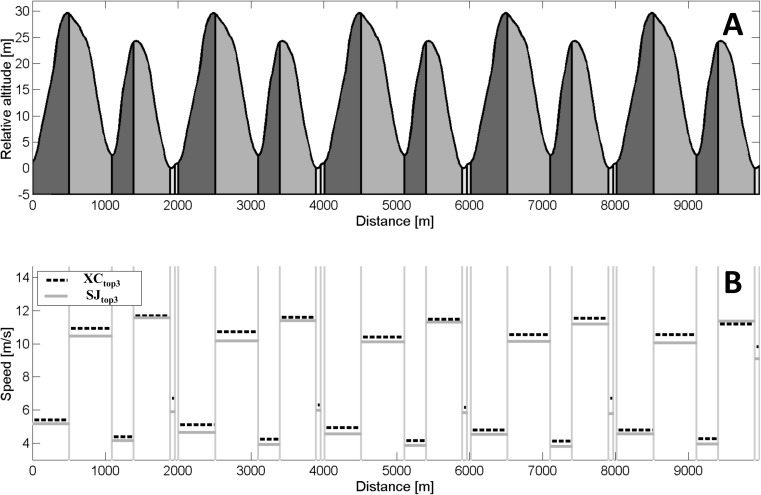
10 km race course profile with average speeds in each segment.The upper graph (A) represents the racecourse profile of the 10 km cross-country race with the relative elevation with regard to zero (start) and uphill, flat, and downhill sections in different tones of gray. The lower graph (B) represents the average speed (m·s-1) in the defined sections for both the top 3 ranked cross-country skiers (XCtop3 in black stapled lines) and the top 3 ranked ski jumpers (SJtop3 in gray solid lines).